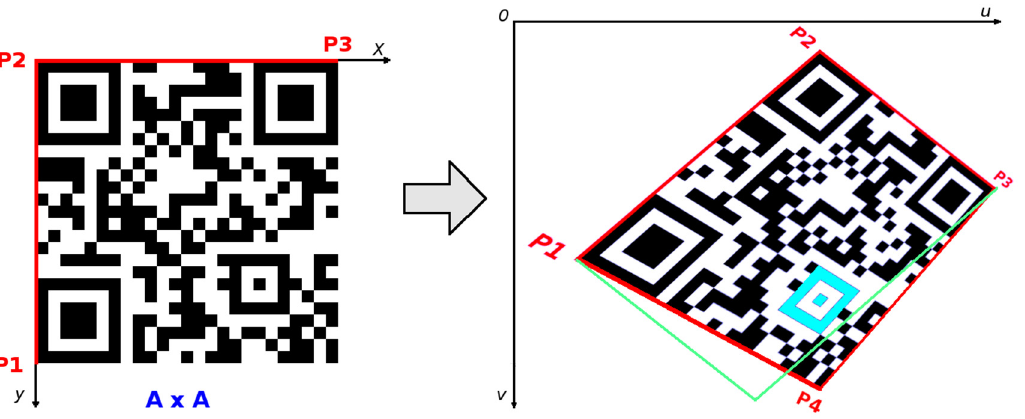
Figure 17. Perspective transformation.